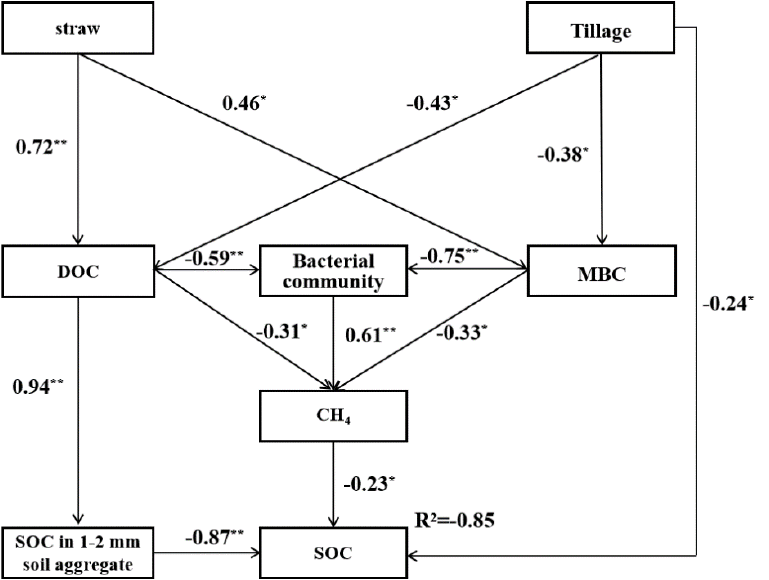
Figure 4. Selected structural equation modeling (data from 2013 rice season and 2014 wheat season were selected) for SOC in 0–5 cm soil layer (The chi-square test = 9.91; Goodness of fit index = 1.00; Comparative fit index = 0.91; Root square mean error of approximation = 0.00), based on the impact of tillage and straw return practices and SOC fractions. Values related to the solid arrows stand for the path coefficients. R 2 indicates the proportion of variance explained. Significance levels are as follows: * p < 0.05; ** p < 0.01. Straw indicates straw systems; DOC indicates dissolved organic carbon; MBC indicates microbial biomass carbon; SOC indicates soil organic carbon.